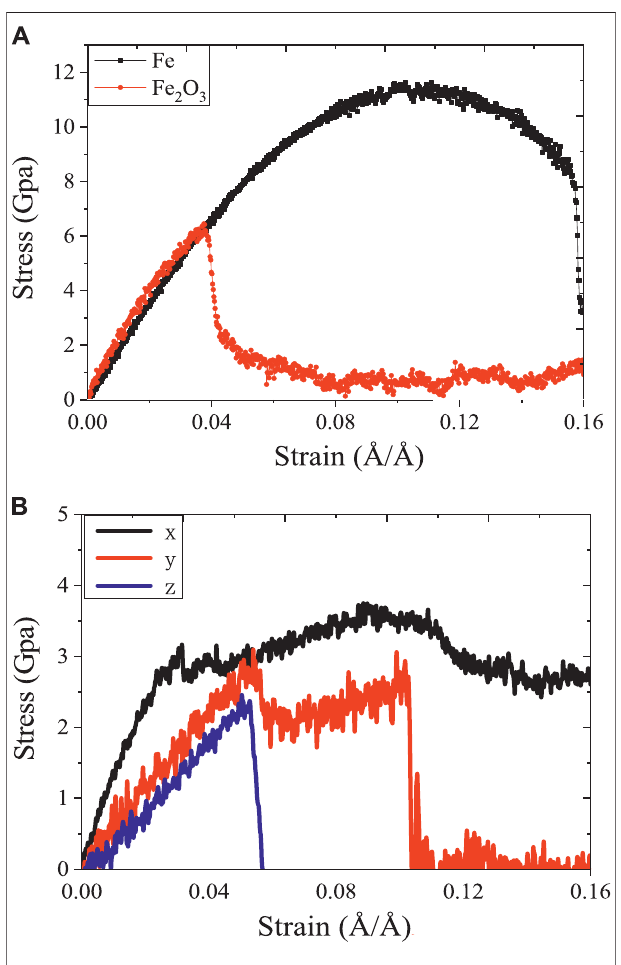
FIGURE 2 | The stress – strain curve of (A) Fe, γ -Fe 2 O 3 along the z direction, (B) stress – strain curve of γ -FeOOH along the x / y / z direction.